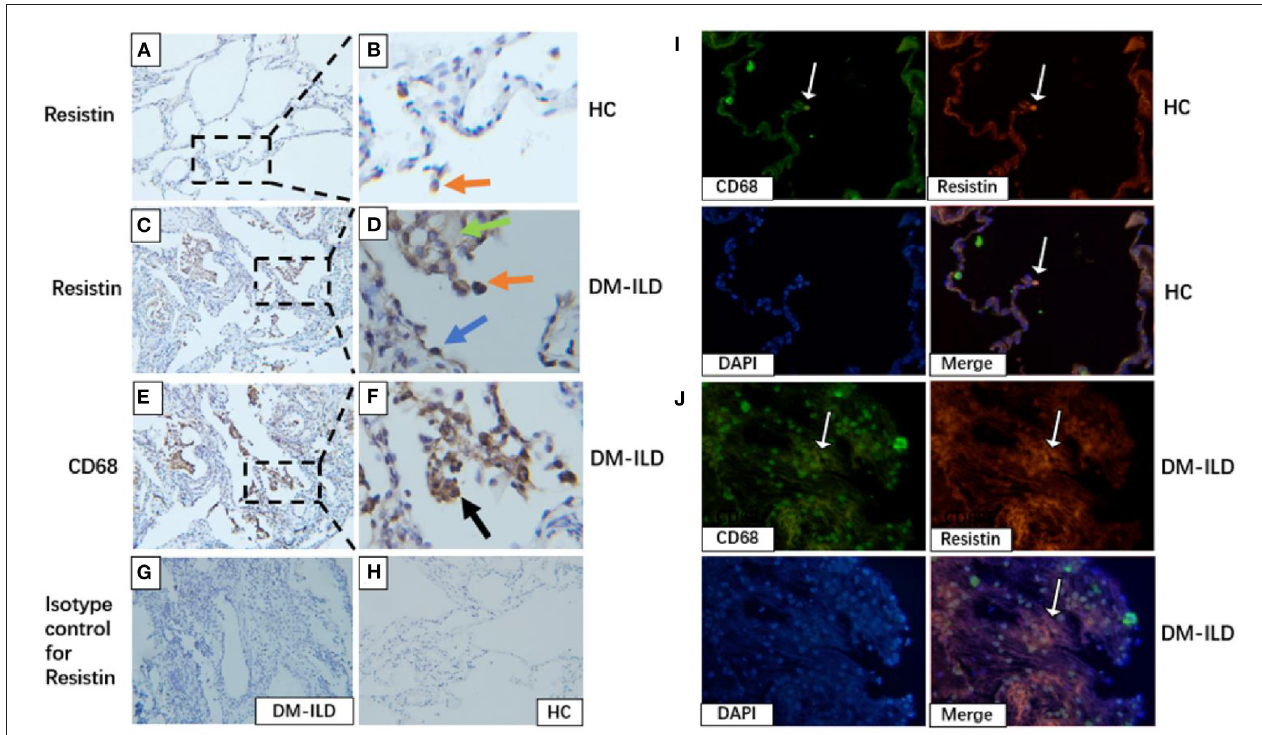
FIGURE 5 | Elevated resistin expression in the lung tissue of patients with DM-ILD. (A,B) Lung of healthy control: A small number of resistin–positive macrophages (red arrowhead). Scale bar = 50 µ m. (C,D) Lung of patients with DM-ILD: Resistin was strongly expressed in macrophages (red arrowhead), alveolar epithelial cells (blue arrowhead), and weak fibrotic lesions (green arrowhead). Scale bar = 50 µ m. (E,F) Lung of patients with DM-ILD: Immunohistochemistry analysis on serial sections using an anti-CD68 antibody confirmed that resistin-positive cells were mostly macrophages (black arrowhead). Scale bar = 50 µ m. (G,H) Isotype-matched control antibody for resistin in DM-ILD and HC. Scale bar = 50 µ m. (I) Lung of healthy control: Two color immunofluorescence of resistin (red) with CD68 + macrophages (green), DAPI (blue). Scale bar = 50 µ m. (J) Lung of patients with DM-ILD: Two color immunofluorescence of resistin (red) with CD68 + macrophages (green). Scale bar = 50 µ m. DM, dermatomyositis; ILD, interstitial lung disease; HC, healthy